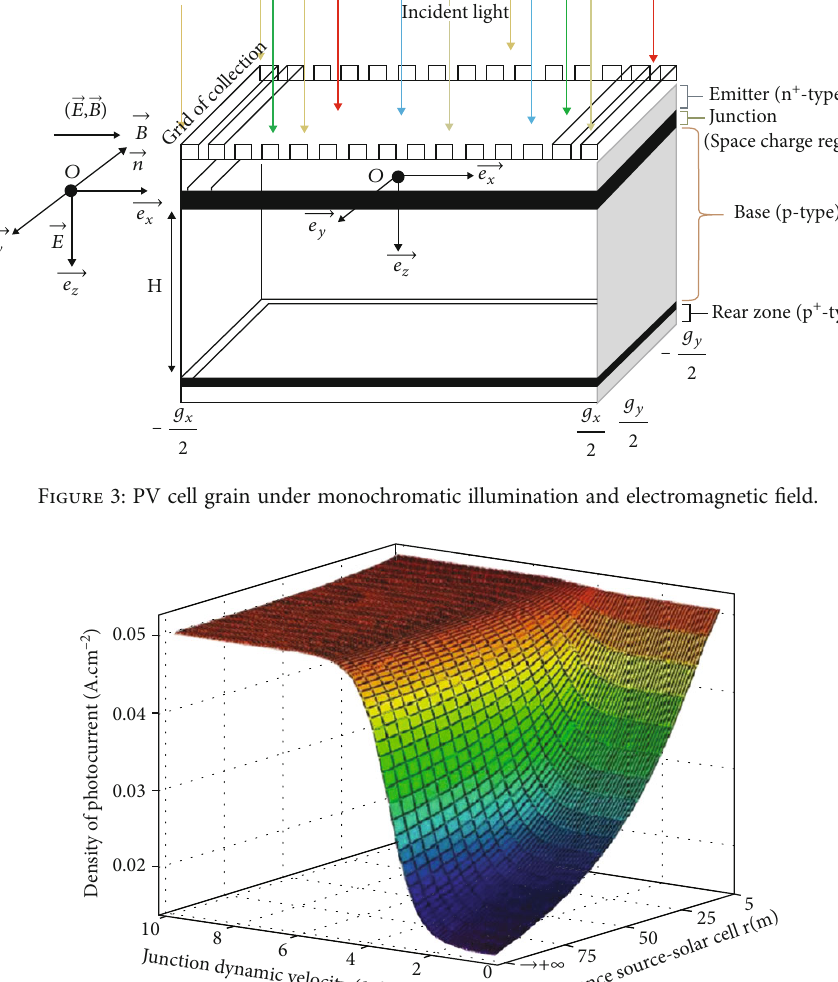
Figure 4: Global current versus the junction dynamic velocity ( S · s − 1 , μ = 1000cm 2 · V − 1 · s − 1 , S n